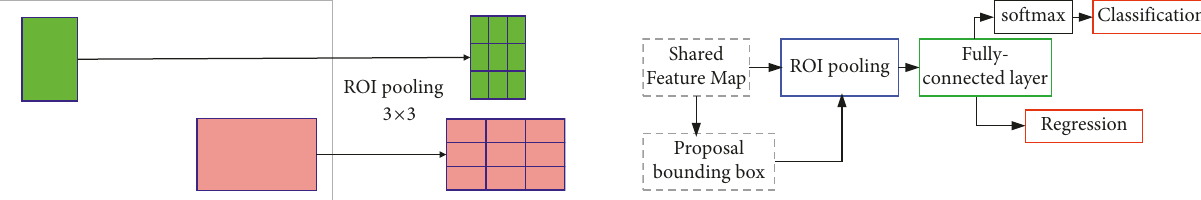
Figure 12: The implantation details of the classification